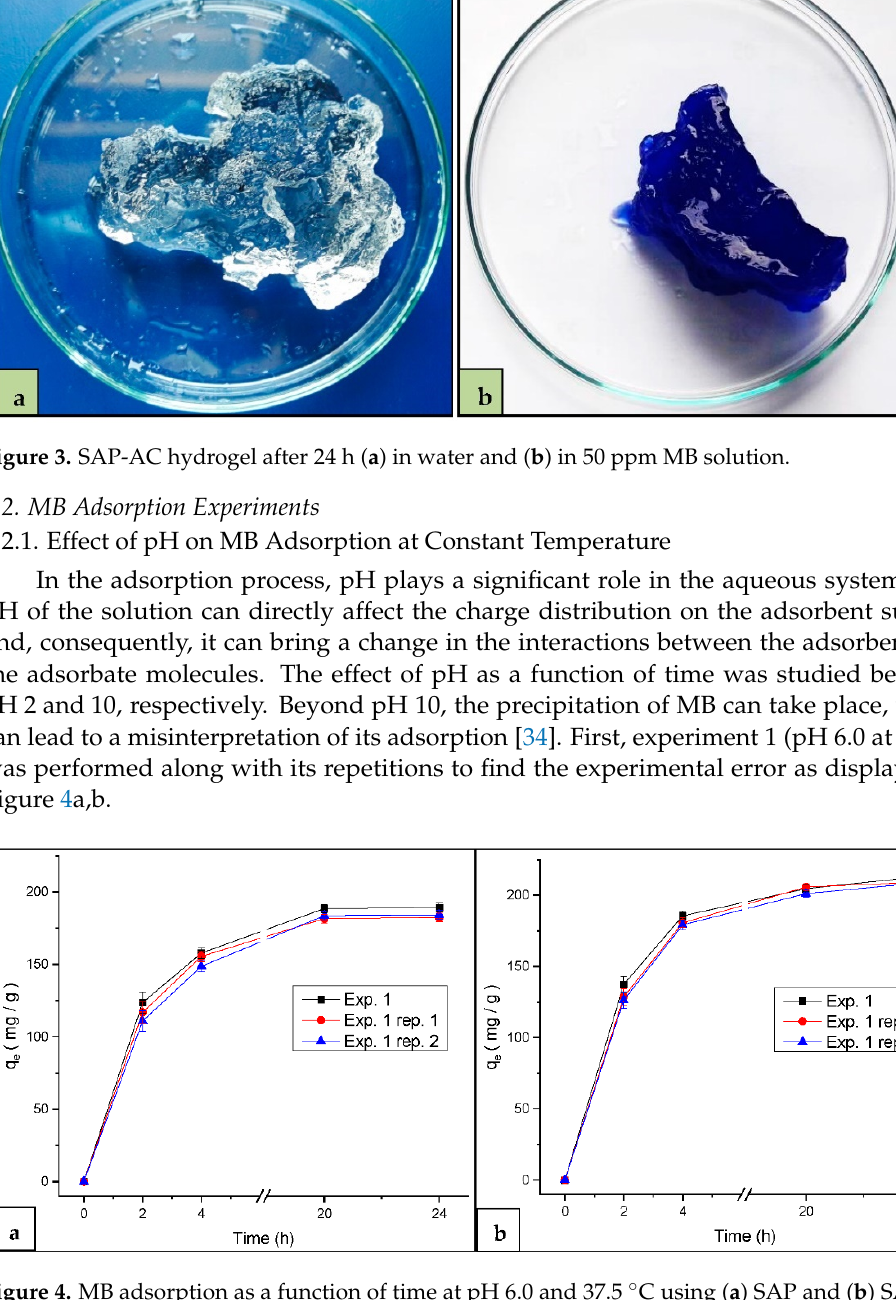
Figure 2. Composite SAP-AC ( a ) 2 wt% and ( b ) 5 wt% by solution mixing and ( c ) freshly prepared SAP-AC (2 wt%) and ( d ) dried SAP-AC by infiltration method.